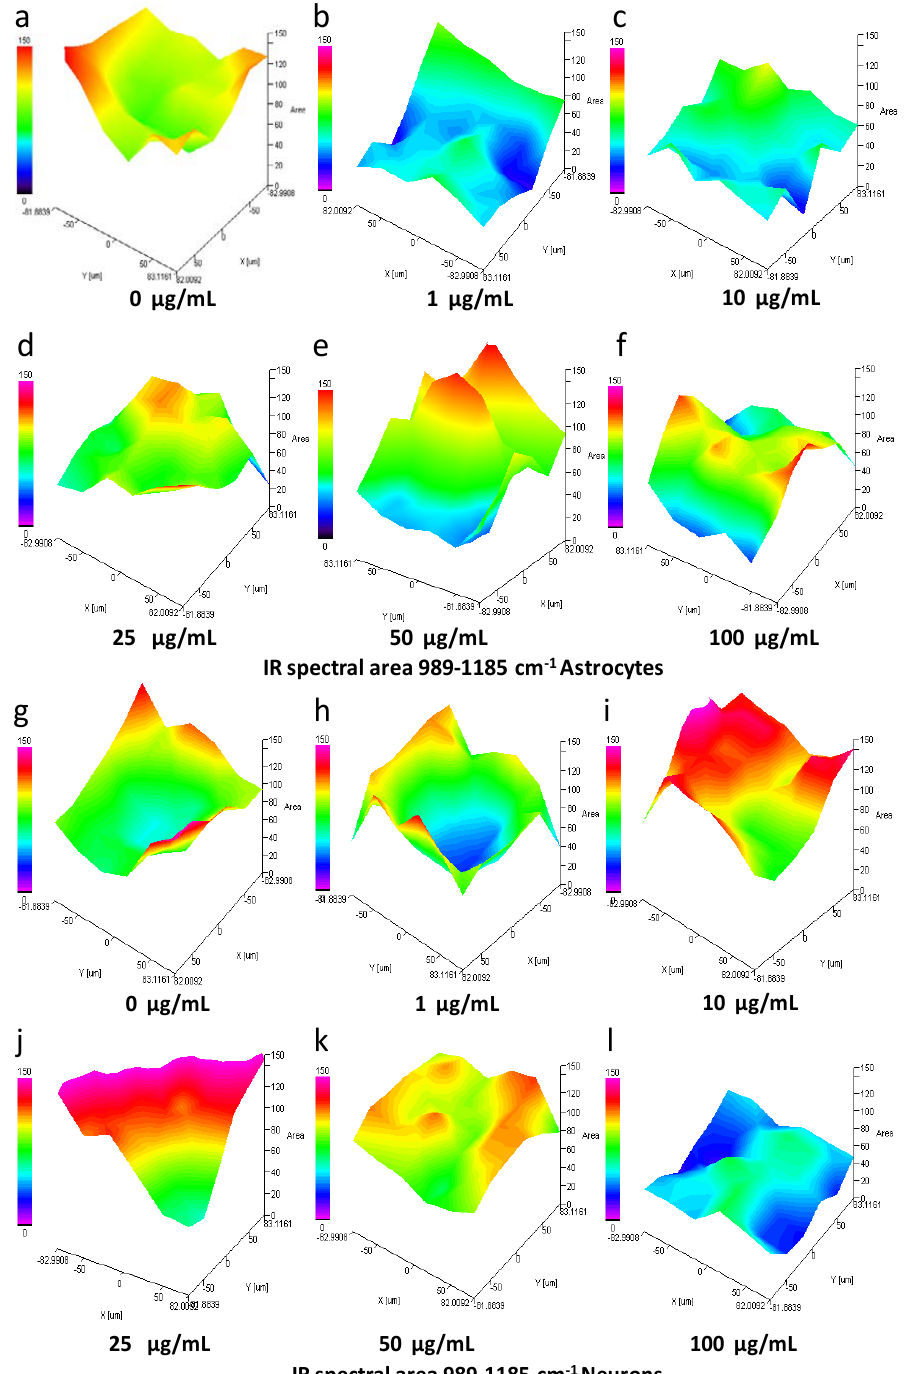
Figure 5. Spectral area analysis by IQ mapping of 989–1185 cm − 1 region of astrocytes and neurons exposed to SiO 2 -NPs. The spectral region of 989–1185 cm − 1 that includes specific spectral bands related to nucleic acids is presented for astrocytes ( a – f ) and neurons ( g – l ). A sample of cells treated with SiO 2 -NPs for 24 h was dispersed on a gold-coated slide. The three-dimensional image is presented in the x, y, and z axes, and the area presented as a gradient of color indicates a decrease (from blue) or increase (red) in the spectral signal. For astrocytes, a decrease in the signal was seen at 1 µ g / mL ( b ) and 10 µ g / mL ( c ) SiO 2 -NPs compared to the control ( a ). Recovery of the signal at 25–100 µ g / mL SiO 2 -NPs ( d – f ) was detected. In neurons, the signal decreased at 1 µ g / mL ( h ) and 100 µ g / mL ( l ); on the contrary, at 10–50 µ g / mL ( i – k ), the signal increased compared to control ( g ). The image is representative of four independent experiments with three technical